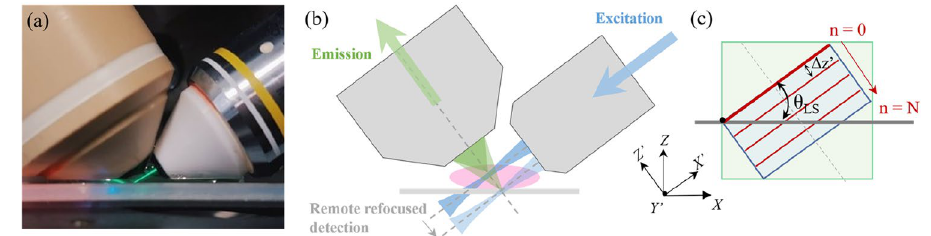
Figure 1. Acquisition geometry for remote-refocusing dual-objective LSFM. ( a ) Detection (left) and illumination (right) objective geometry, with fluorescein emission used to visualize the light sheet. ( b ) Schematic of illumination and detection geometry, with the remote refocused detection synchronized with the scanning of the light sheet. ( c ) Remote refocusing volumetric acquisition geometry, with the focus swept along the Z ’ detection axis (dashed grey line), with consecutive images separated by distance Δ z’ along the detection axis, with the sample remaining stationary. The light-sheet angle with respect to the horizontal surface is indicated by θ LS